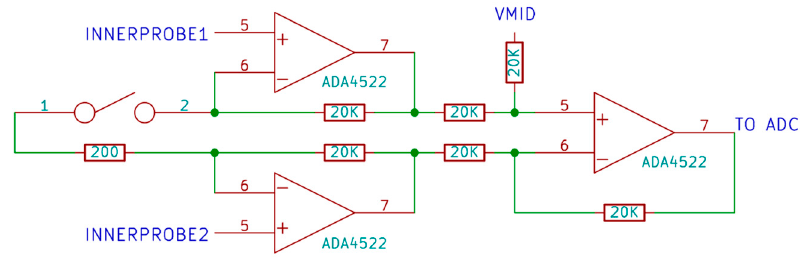
Figure 7. Instrumentation amplifier circuit.